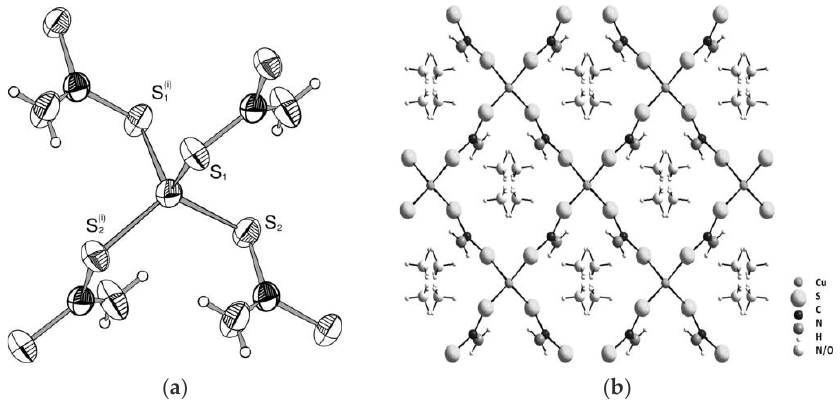
Figure 15. Representations of the solid-state structure of [NH 4 ][Cu(S 2 CNH 2 ) 2 ] ‧ H 2 O showing ( a ) the coordination geometry around each Cu(II) ion and ( b ) the 2D framework. Reproduced with permis- sion from [114]. Copyright 2013 John Wiley and Sons.